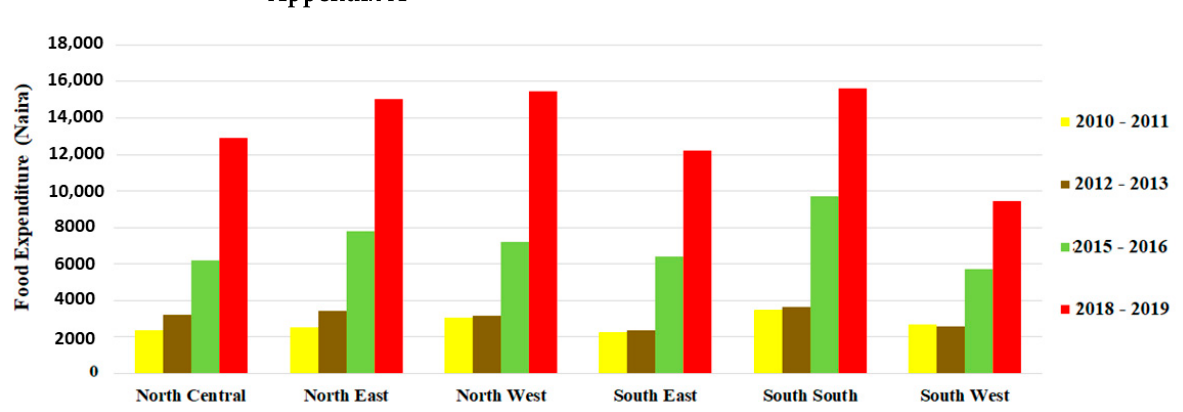
Figure A1. Food expenditure per week for grains and flours, starchy roots, tubers and plantains, pulses, nuts, and seeds, vegetables, meat, fish, and animal products for the 6 geopolitical zones from 2010 to